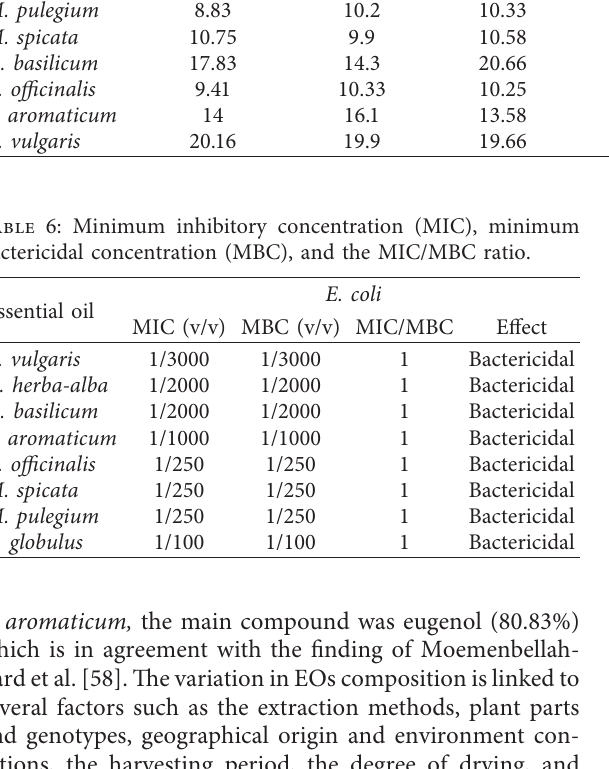
Table 5: Inhibition zone diameter (mm) of the essential oils on Escherichia coli strain isolated from different organs of turkey. Essential oil